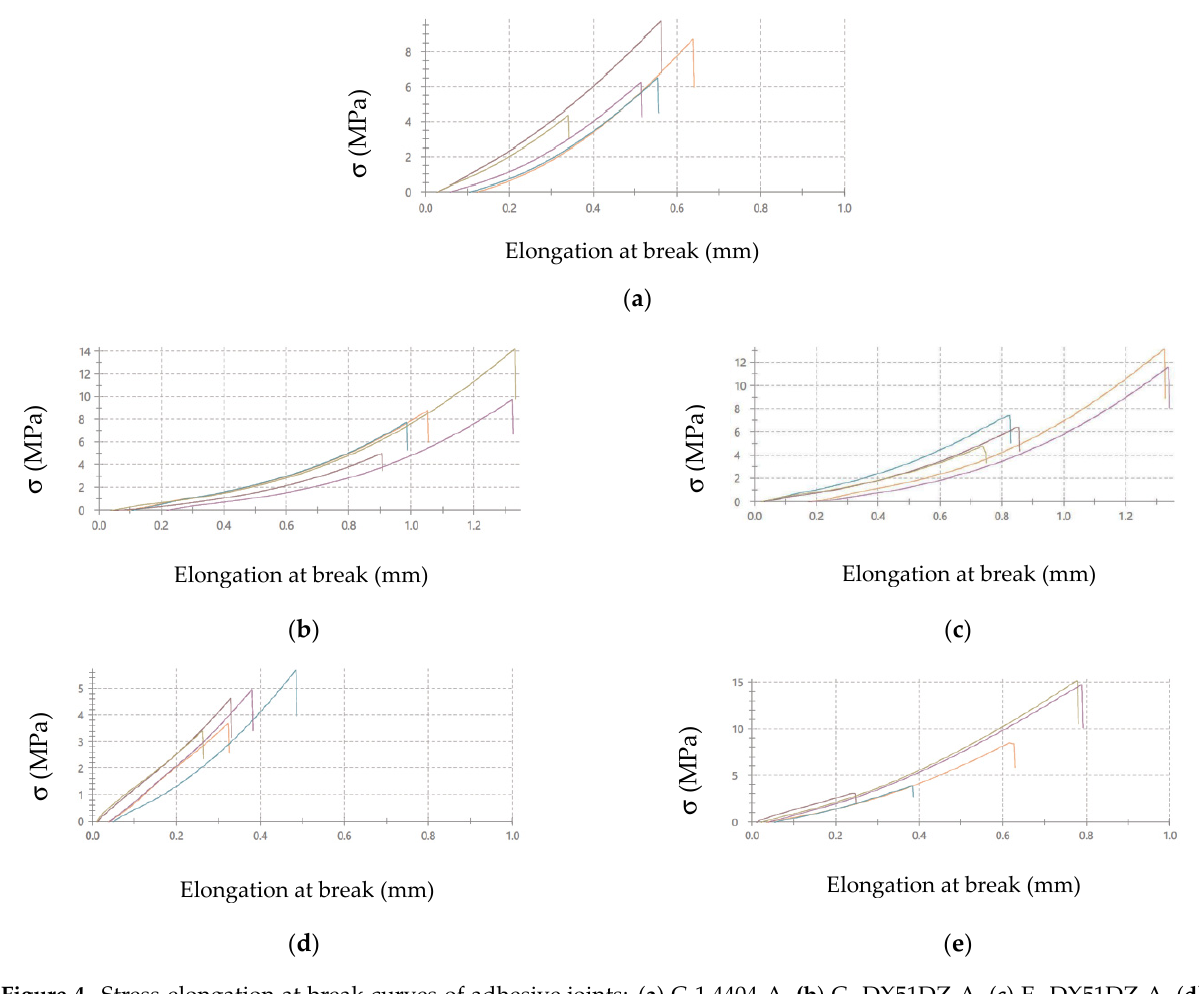
Figure 4. Stress-elongation at break curves of adhesive joints: ( a ) C-1.4404-A, (b ) C- DX51DZ-A, ( c ) E- DX51DZ-A, ( d ) C-50CRV4-A, ( e ) E-50CRV4-A (designations according to Table 5).